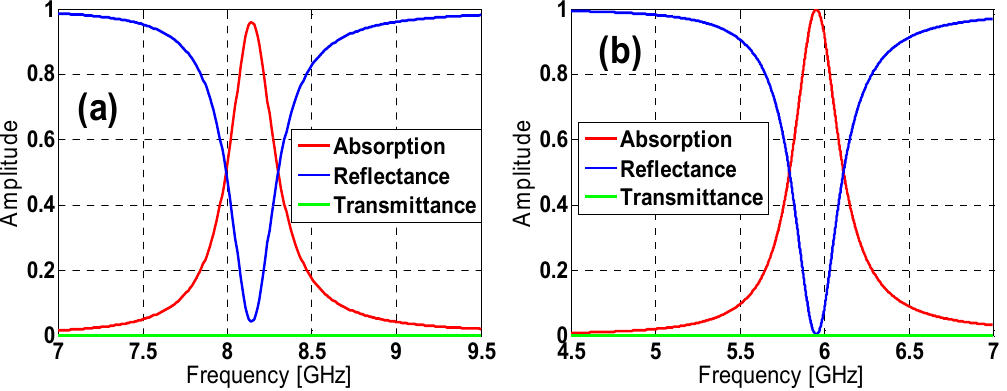
Figure 2. Absorption, reflection and transmission: ( a ) hexagon and ( b ) star